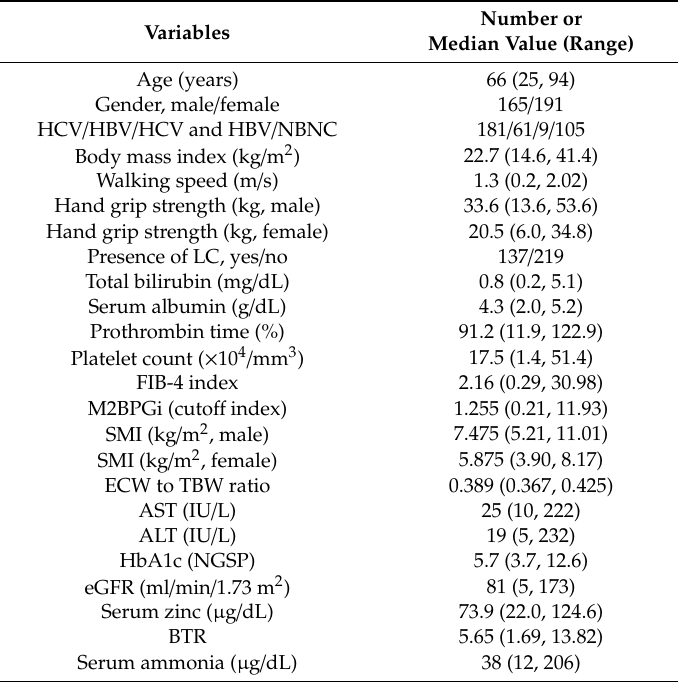
Table 1. Baseline characteristics (n =